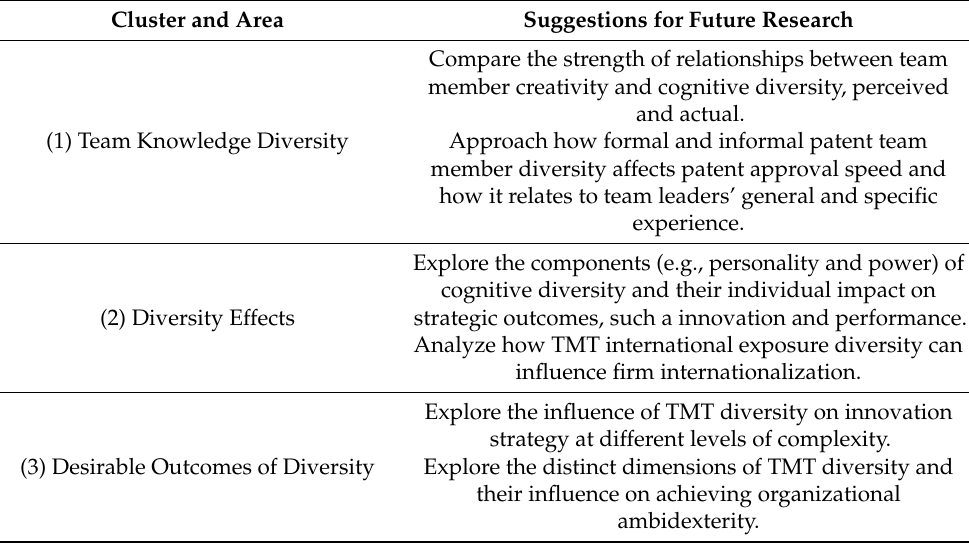
Table 7. Summary of suggestions for future